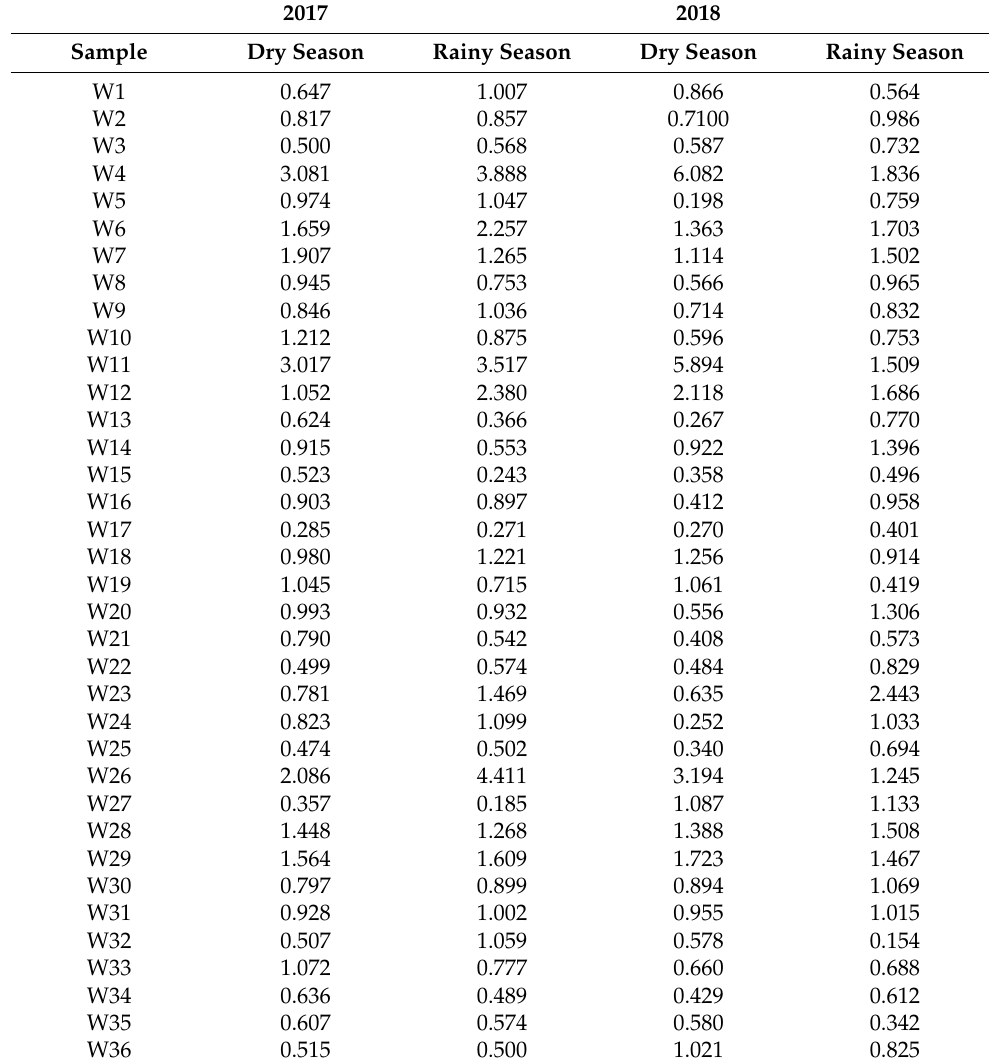
Table 4. Non-carcinogenic risk assessment for